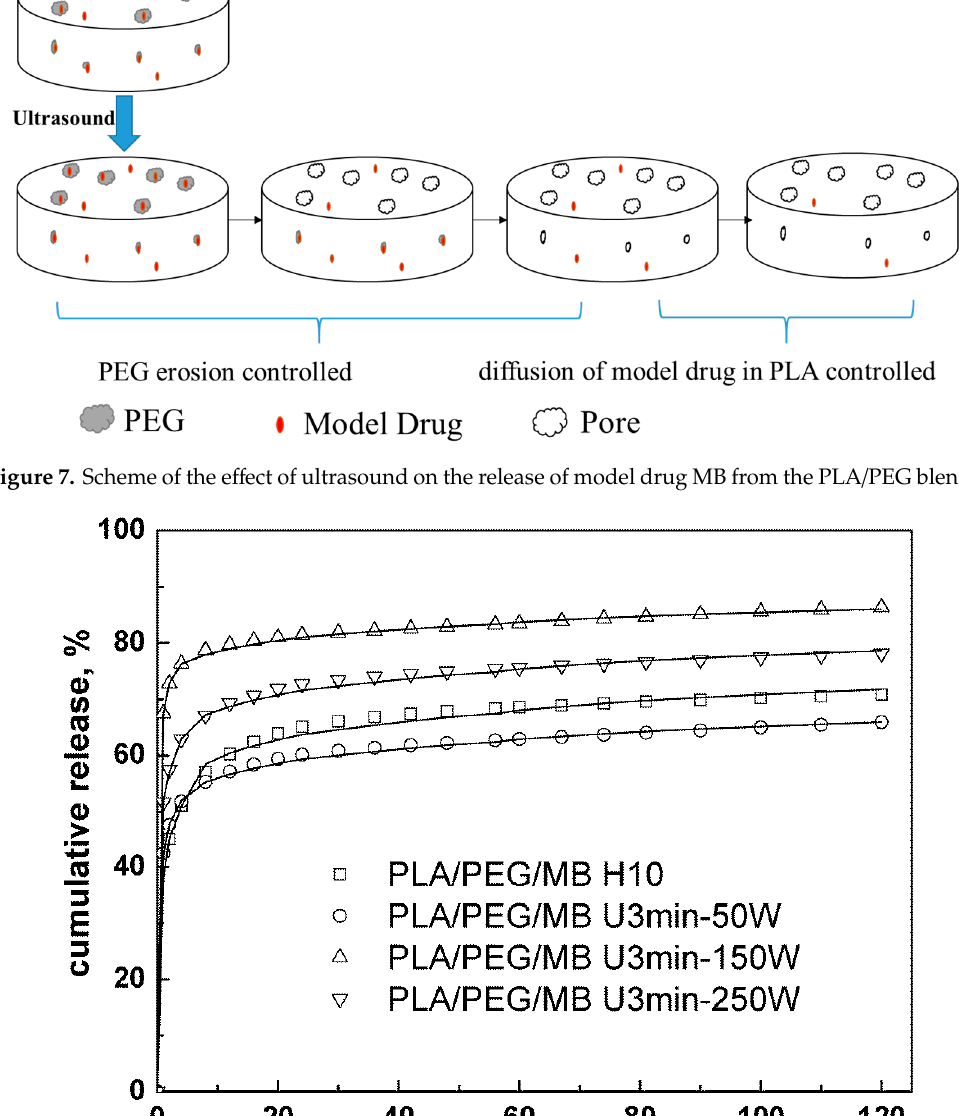
Polymers 2018 , 10 , x FOR PEER REVIEW Table 6. Effect of ultrasound on kinetics parameter, Q , erosion release constant, k 1 , and diffusion